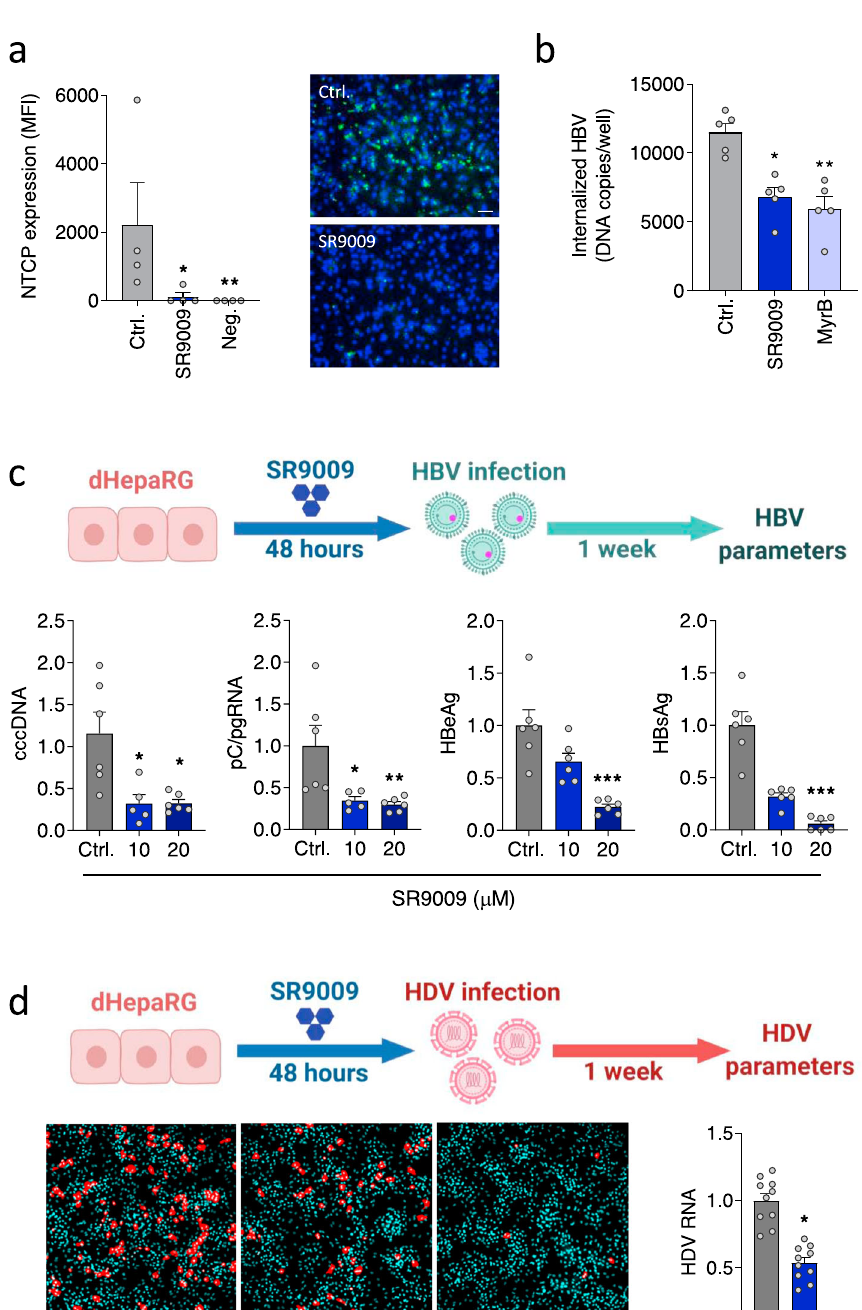
Fig. 3 Pharmacological activation of REV-ERB inhibits HBV and HDV infection. a dHepaRG cells were treated with SR9009 (20 µ M, 48 h) and NTCP expression assessed using Myrcludex B (MyrB) tagged with Alexa 488 fl uorophore. Unstained cells were used as the negative control. Median fl uorescence intensity was quanti fi ed (mean ± SEM, n = 4, Kruskal – Wallis ANOVA with Dunn ’ s test). Representative fl uorescent images are shown (scale bar = 100 µ m). b dHepaRG cells were treated with SR9009 (20 µ M) or MyrB (200 nM) and inoculated with HBV at 4 °C for 3 h. Unbound virus was removed by washing and the inoculated cells incubated at 37 °C for 16 h, trypsinized to remove non-internalized virus and intracellular HBV DNA levels quanti fi ed by qPCR and presented as copies per well (mean ± SEM, n = 5, Kruskal – Wallis ANOVA with Dunn ’ s test). c dHepaRG cells were treated with SR9009 (10 or 20 µ M) for 48 h and inoculated with HBV for 6 h. 1 week post-infection, cccDNA, pC/pgRNA, HBeAg and HBsAg were quanti fi ed by qRT- PCR or ELISA assay. In all cases, data are expressed relative to untreated (Ctrl) cells (mean± SEM, n = 6, Kruskal – Wallis ANOVA with Dunn ’ s test). d dHepaRG cells were treated with SR9009 (20 µ M) for 48 h and inoculated with HDV and 7 days post-infection, HDV antigen (HDAg) and viral RNA measured by fl uorescent staining or qRT-PCR. MyrB was included as the positive control to assess NTCP-dependent HDV infection (mean ± SEM, n = 8 – 10, Kruskal – Wallis ANOVA with Dunn ’ s test). * p < 0.05, ** p < 0.01, *** p < 0.001. Data are provided in the accompanying Source Data fi le.